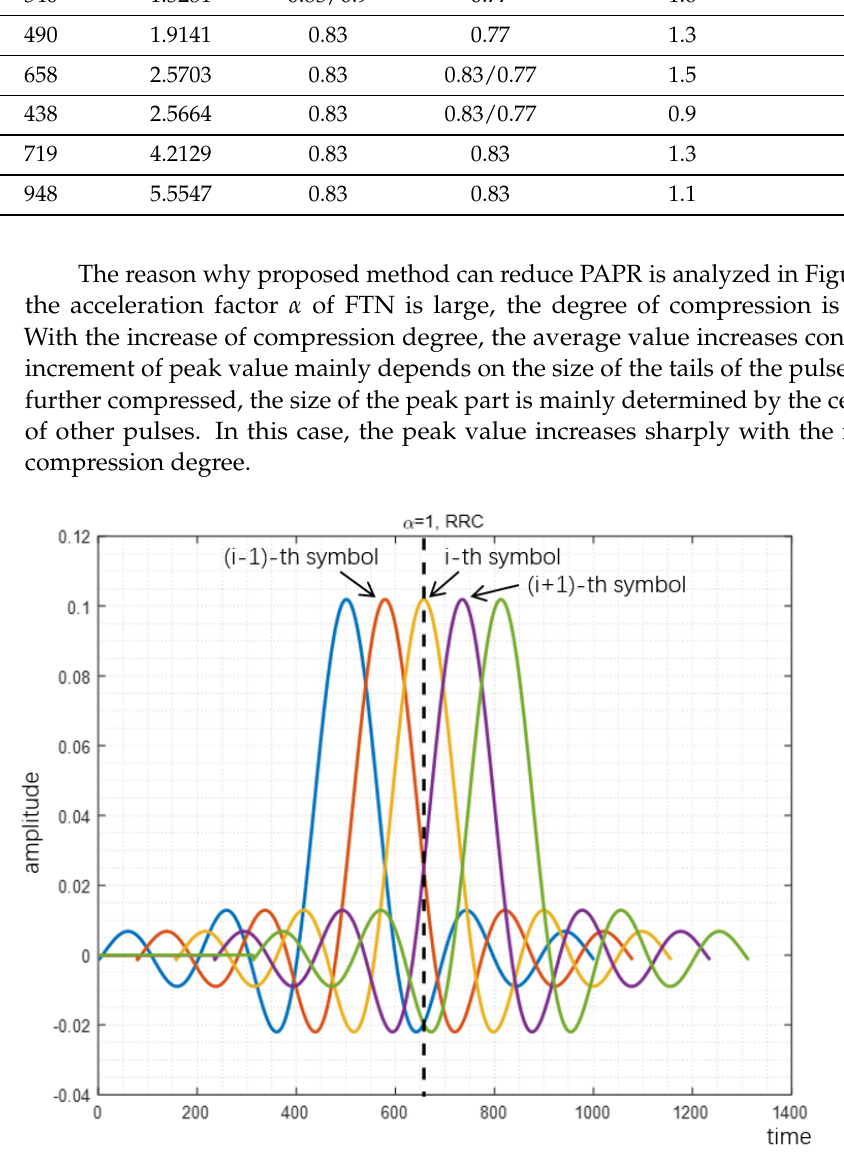
Figure 7. Peak value of RRC filter-based signal with α =